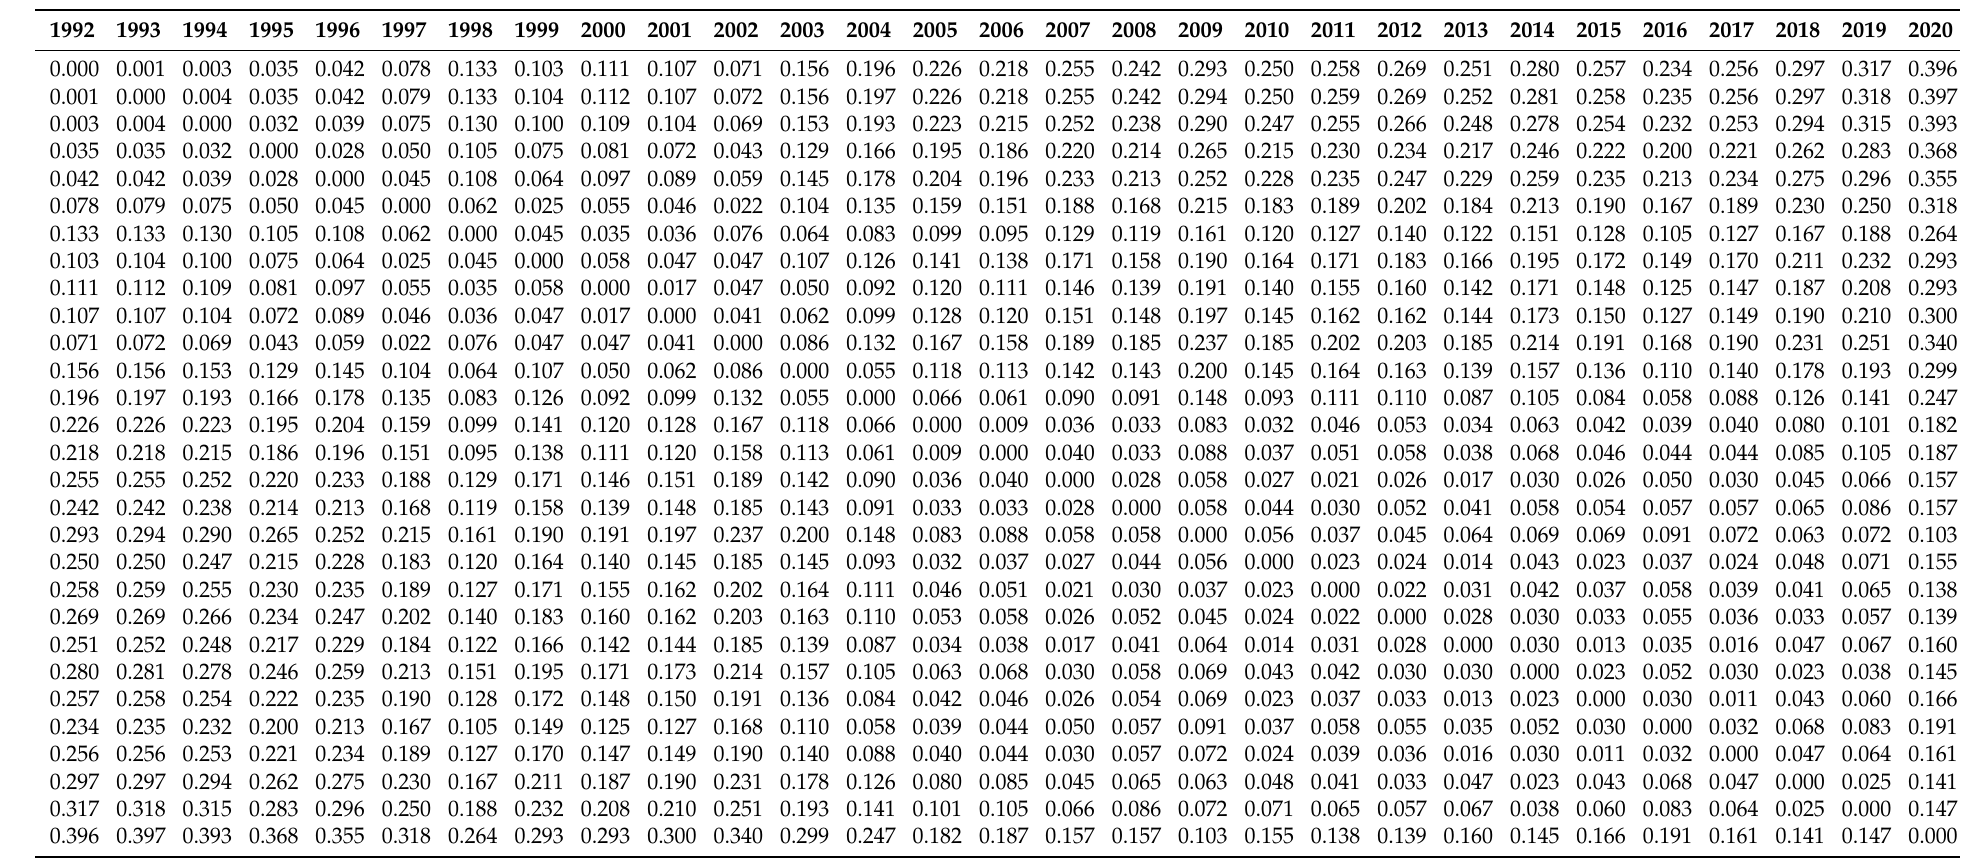
Table A3. Intensity of changes in the structure (NPS) of the sales in mining enterprises in Poland in